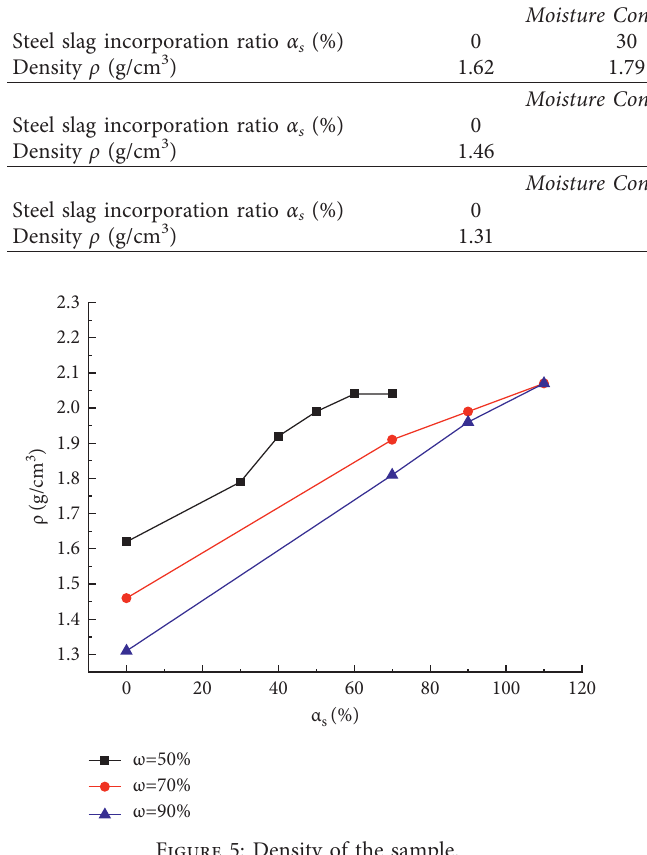
Table 4: Density of samples.